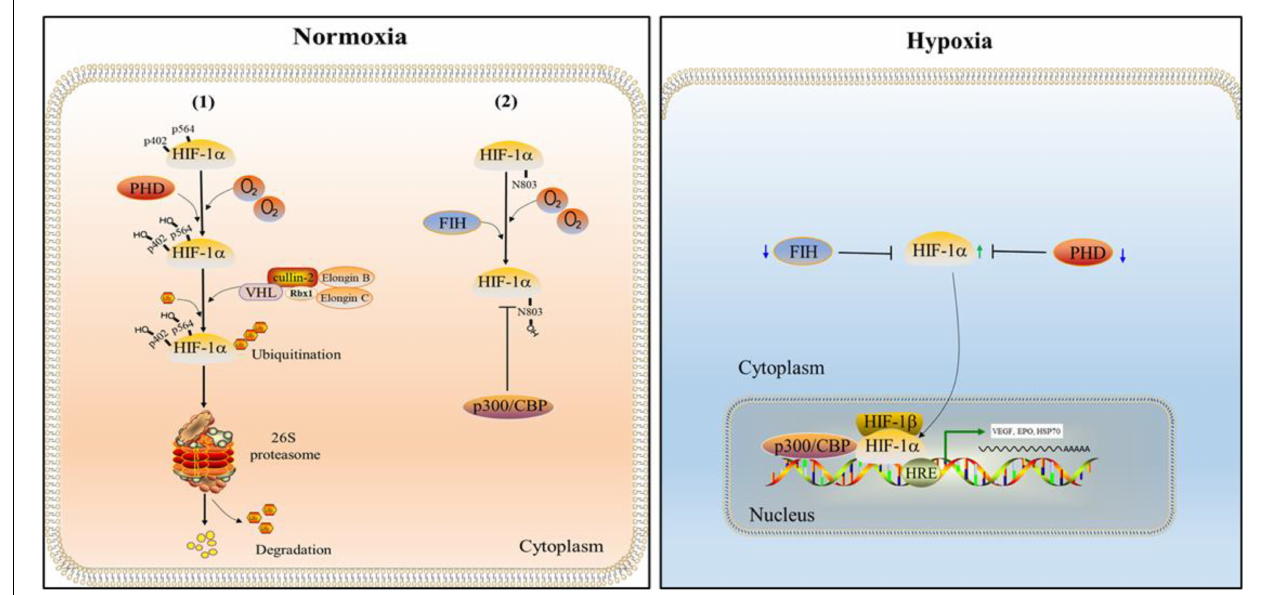
FIGURE 5 | The regulation of HIF-1. Under the normal oxygen condition, the prolyl residues at sites 402 and 564 of HIF-1 α are hydroxylated by the prolyl hydroxylase domain (PHD). Subsequently, hydroxylated HIF-1 α is ubiquitinated by Von Hippel-Lindau (VHL) and degraded by 26S proteasome. In addition, the asparagine residue (N803) of HIF-1 α is hydroxylated by the factor inhibiting HIF (FIH) which inhibits the connection between p300/CBP and C-TAD, thereby reducing the transcriptional activity of HIF-1 α . When hypoxia occurs, the activities of FIH and PHD are inhibited. Therefore, HIF-1 α can enter the nucleus to form complexes with HIF-1 β and p300/CBP, and promote the transcription of hypoxia response genes and cause a series of adaptive responses of cells to